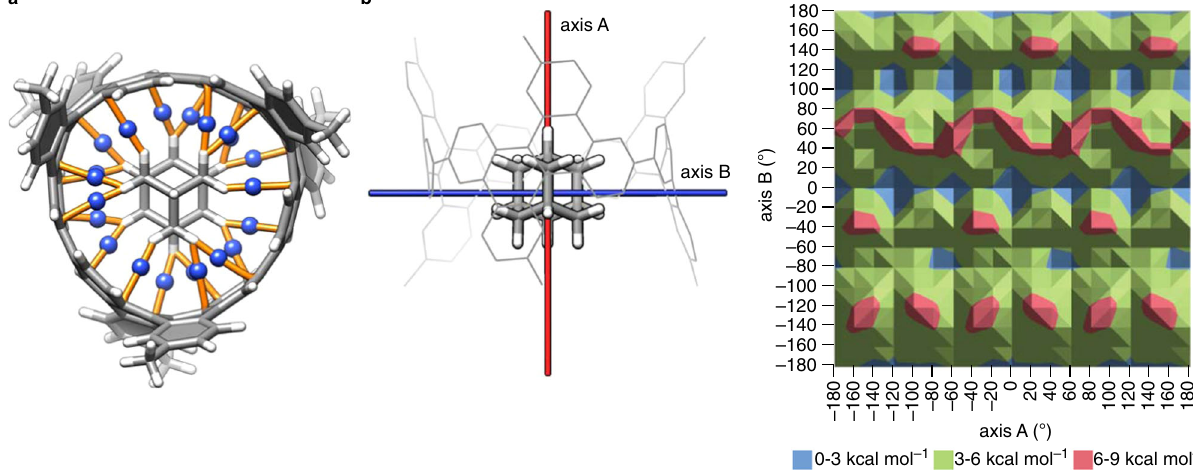
Fig. 4 Theoretical pictures of hybrid nanocarbon peapods. a Hydrogen bonds at the interface of [3]C db C ⊃ adm . Bond paths (orange) and (3, – 1) bond critical points (blue) from AIM analyses are shown. b Energy pro fi le for the hypothetical rotations of adm within [3]C db C . The most stable global minimum is located at (A,B) = (0,0). See also Supplementary Movies 1 and